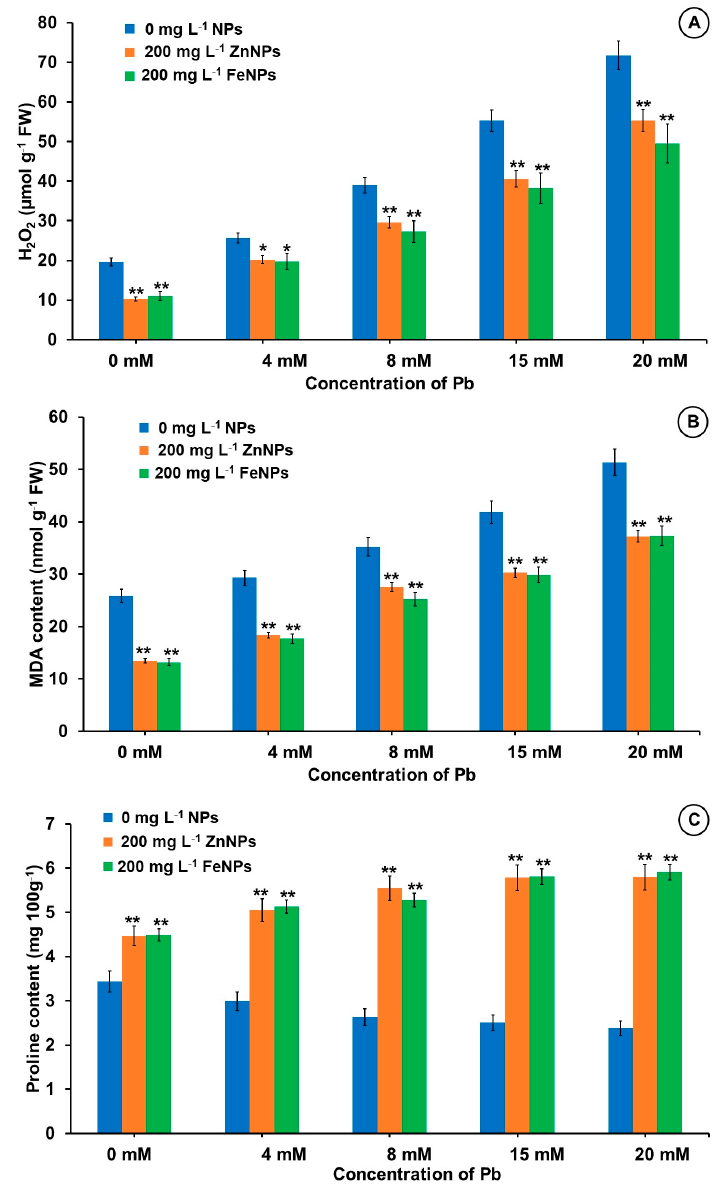
Figure 5. Effects of Pb and nanoparticles (ZnNPs and FeNPs) on ( A ) H 2 O 2 content, ( B ) MDA content and ( C ) proline content of 20-day-old B. alba seedling. Error bars representing the standard error. Asterisks above the error bars denote significant differences between treatments in comparison to respective treatment without NPs (* = p value < 0.05 and ** = p value < 0.01, Duncan’s Multiple Range Test).